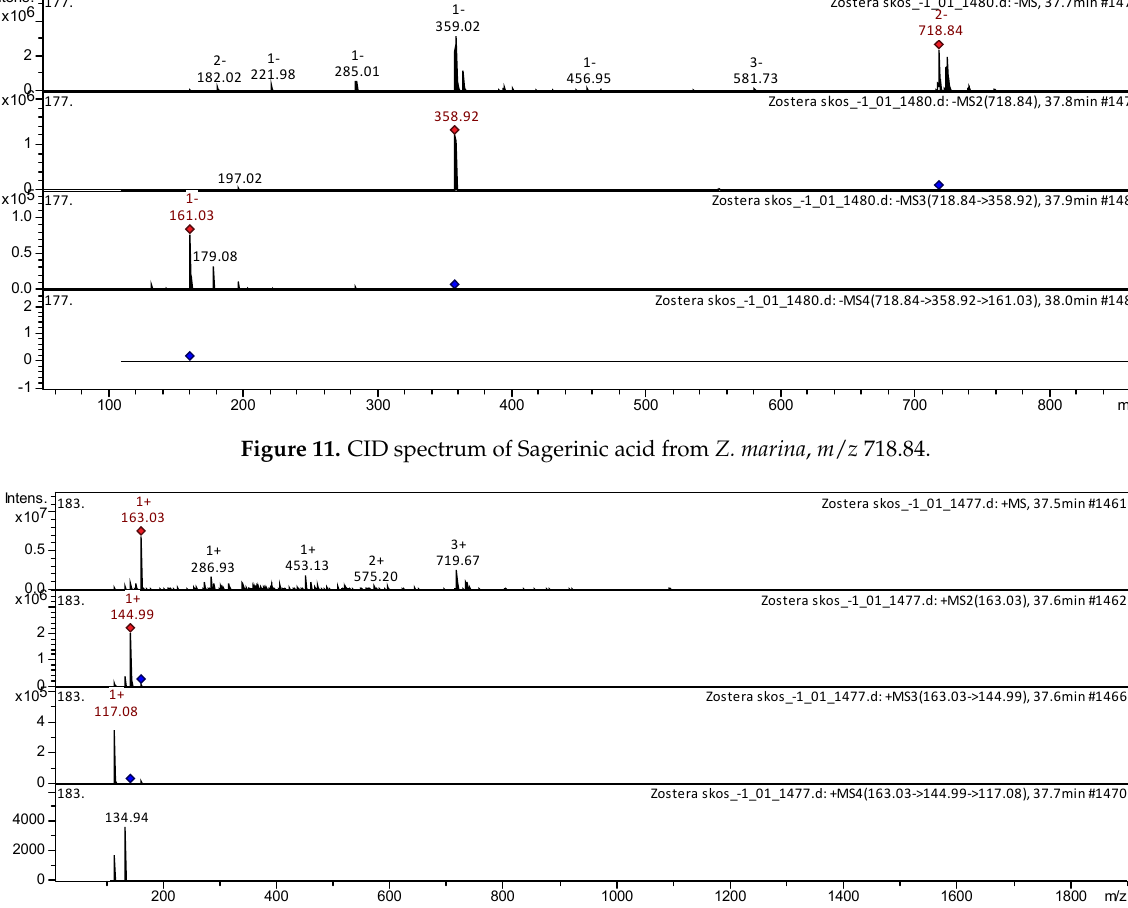
The CID spectrum in negative ion modes of phenolic acid Sagerinic acid from Z. ma-